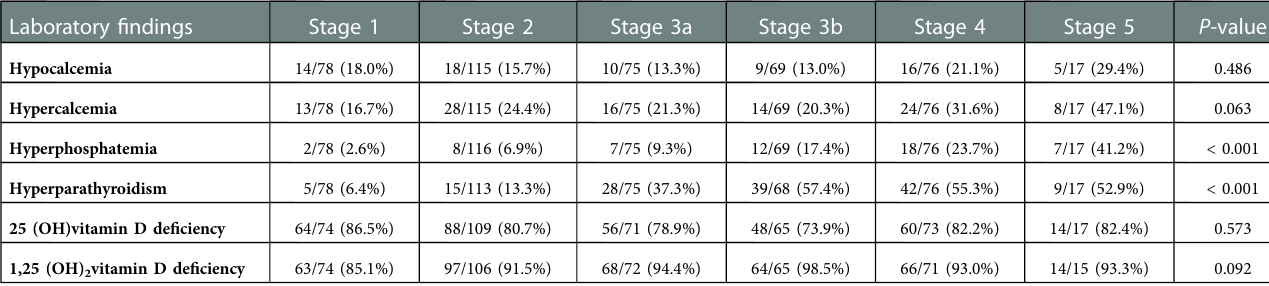
TABLE 2 Prevalence of disordered mineral metabolism in the KNOW-Ped CKD cohort according to CKD stages. Laboratory fi ndings